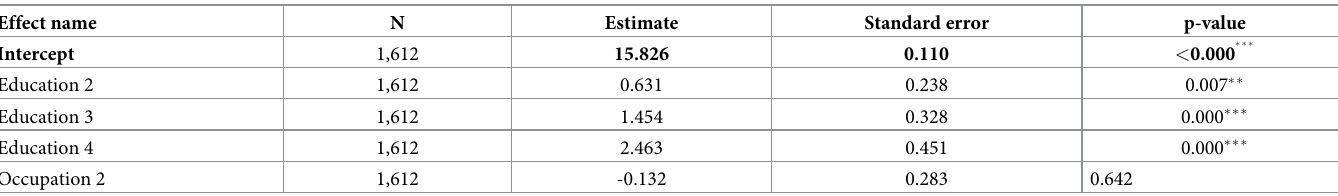
Table 1. Parametric coefficients for women’s SES effects on age at